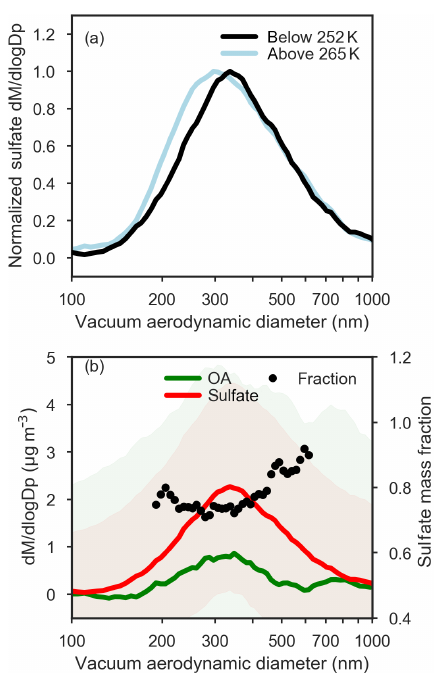
Figure 9. (a) Normalized mean ToF-AMS size distributions of sul- fate subset by observed potential temperature: below 252K (black), above 265K (light blue). (b) ToF-AMS size distributions of sulfate (red) and total organic aerosol (green) below 252K. The mass frac- tion of sulfate calculated from ToF-AMS size distributions is shown on the right axis in black circles, and is calculated only between 200 and 600nm owing to low OA signals at smaller and larger sizes. Shading corresponds to ± 1 standard deviation for sulfate and or- ganic aerosol size distributions, and the relatively large variation in size-resolved composition indicates that the derived mass fraction of sulfate as a function of size is